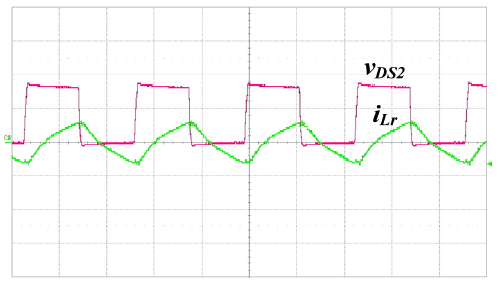
Figure 8. Measured voltage v DS 2 (200 V/div) and inductor current i Lr (1 A/div); time scale: 5 μ s/div.